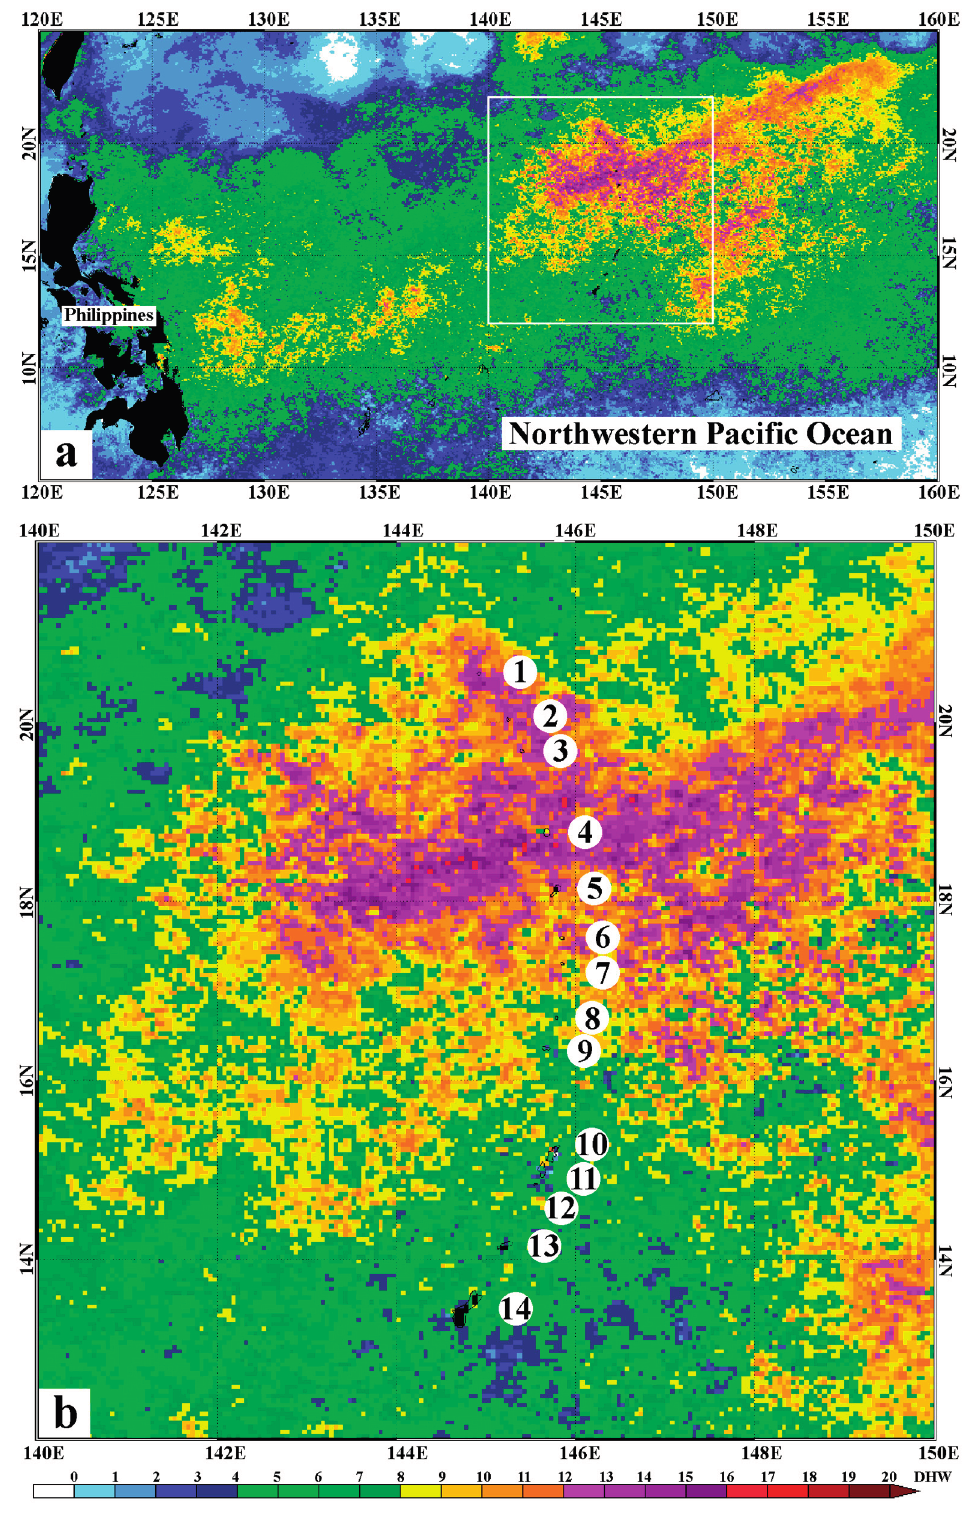
Figure 9. CRW’s daily 5-km DHW maps of the tropical northwestern Pacific Ocean ( a ) and CNMI/Guam ( b ) of 24 August 2014; the box in (a) shows the spatial coverage of (b). Location names: 1, Uracas; 2, Maug Islands; 3, Asuncion; 4, Agrihan; 5, Pagan; 6, Alamagan; 7, Guguan; 8, Sarigan; 9, Anathan; 10, Saipan; 11, Tinian; 12, Aguijan; 13, Rota; 14,